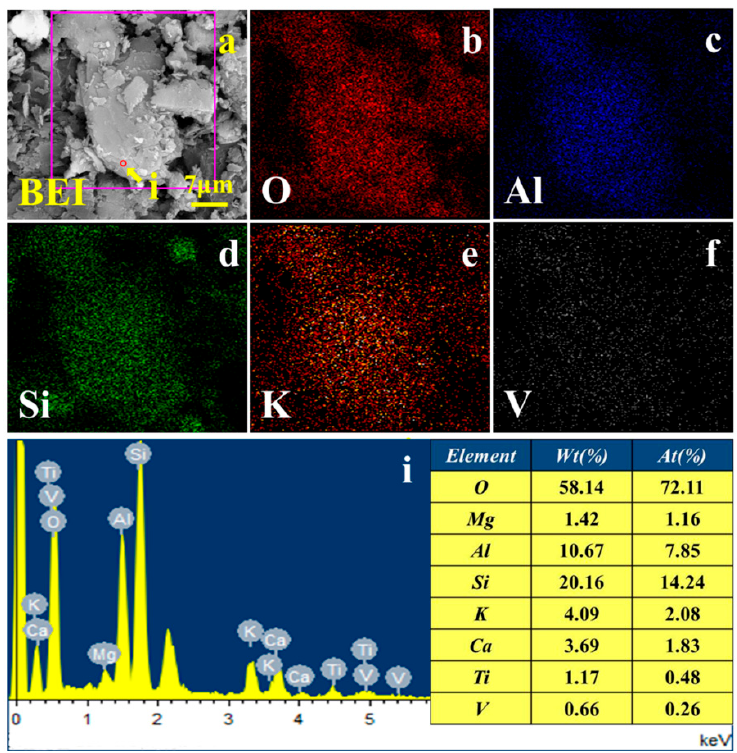
Figure 2. ( a ) BEI of raw stone coal; EDS elemental distribution: ( b ) O; ( c ) Al; ( d ) Si; ( e ) K; ( f ) V; ( i ) EDS spectra marked from BEI by circle.